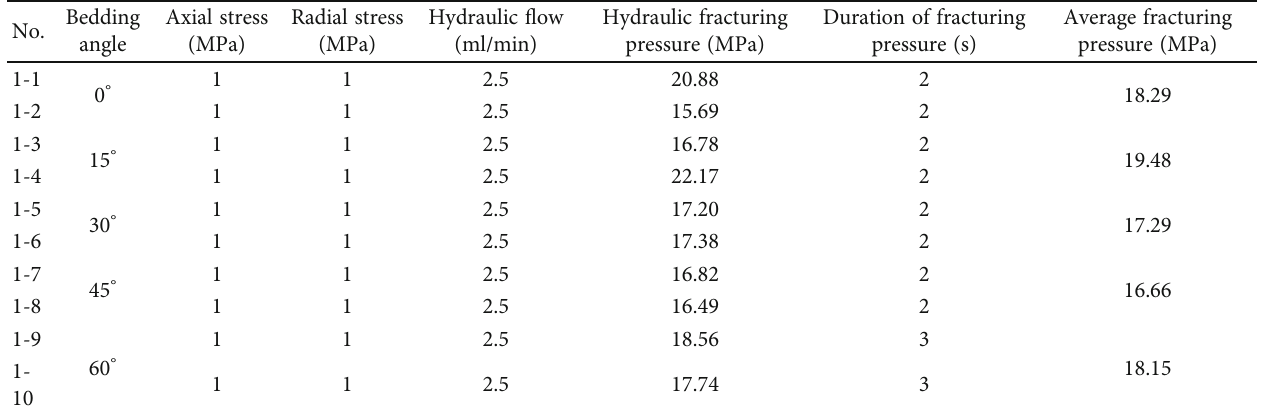
Figure 6: Hydraulic pressure curves of samples during hydraulic fracturing. (a) Samples 1-1, 1-3, 1-5, 1-7, and 1-9. (b) Samples 1-2, 1-4, 1-6, 1-8, and 1-10. (c) Average fracturing pressure. Table 2: Experimental results of sandstone samples due to hydraulic